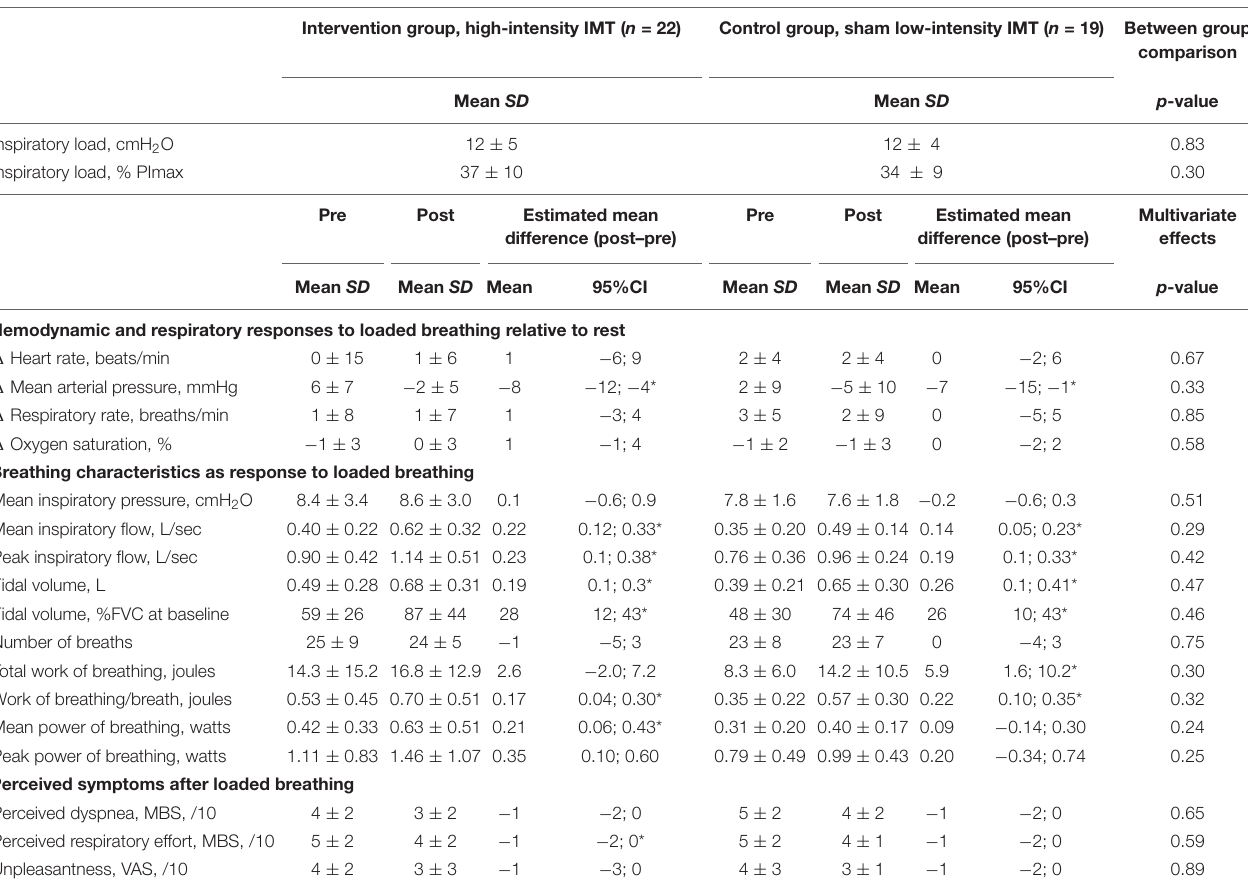
TABLE 4 | Breathing characteristics, hemodynamic responses and symptoms during the sandardized loaded breathing tasks. Intervention group, high-intensity IMT ( n =